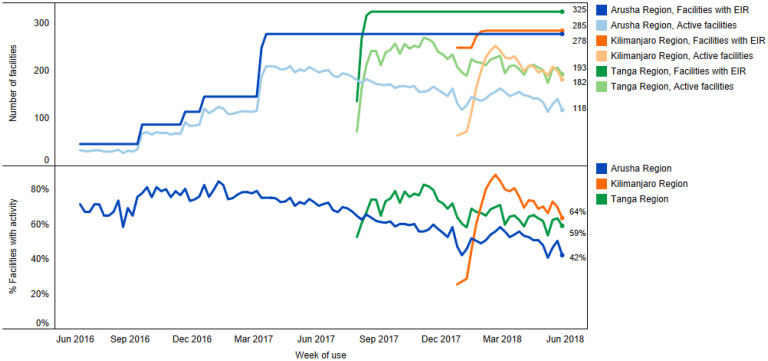
Number of Facilities in Tanzania Using the EIR (top) and Percentage of Facilities Using the EIR (bottom)Abbreviation: EIR, electronic immunization registry.